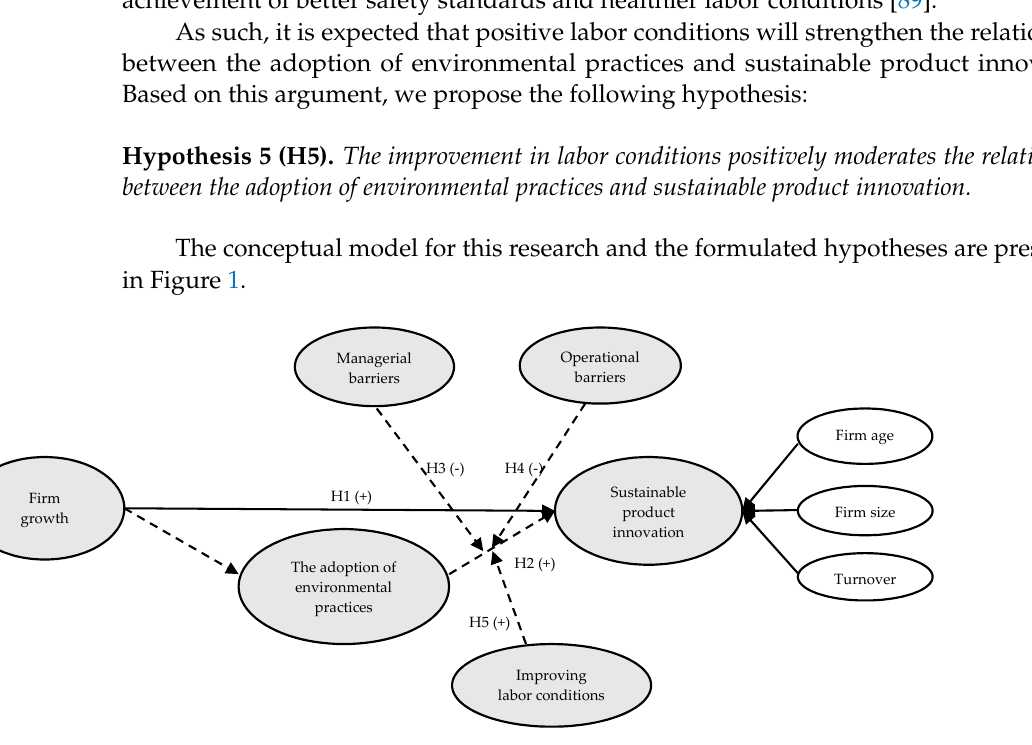
Figure 1. Conceptual model. Note : + positive relationship, - negative relationship.